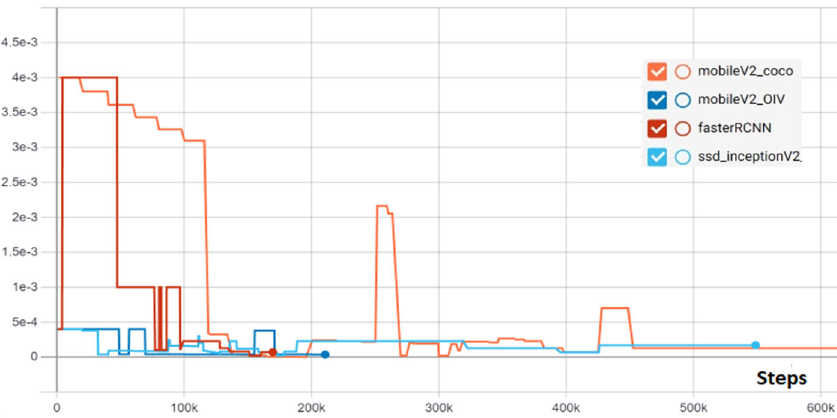
Figure 6. Learning rates of the convolutional neural network (CNN) models.